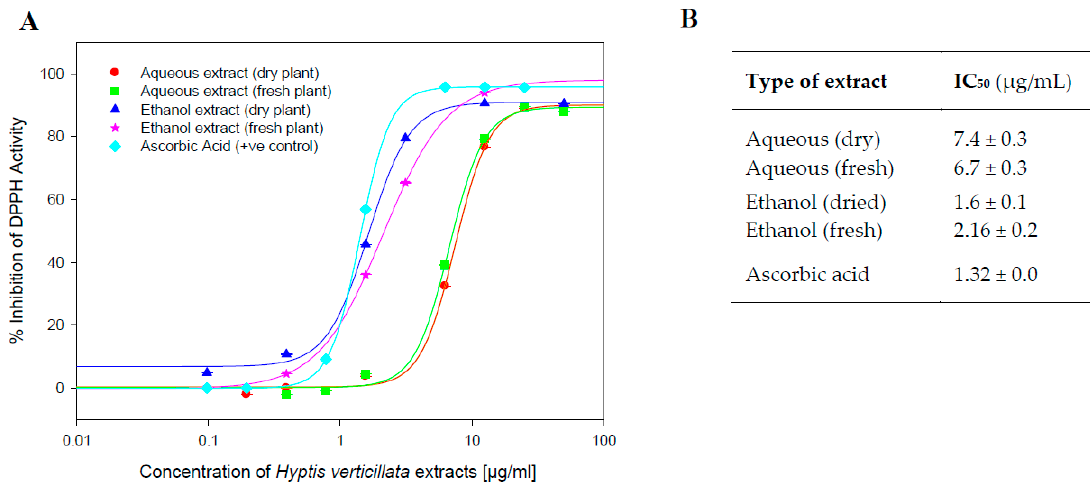
Figure 2. ( A ) DPPH antioxidant assay for H. verticillata extracts. Antioxidant capacity was determined in the presence of varying concentrations of reconstituted freeze-dried aqueous extracts and ethanol extracts of H. verticillata from both fresh and dry aerial plant material ranging from 0.097 to 50 µg/mL, as described in the Materials and Methods section. Positive control activity was determined in the presence of varying concentrations of known antioxidant, ascorbic acid, ranging from 0.097 to 50 µg/mL. Data are expressed as Mean Percentage Antioxidant Activity (% Inhibition of DPPH) for duplicate assays for at least two independent experiments. ( B ) Summary of results.